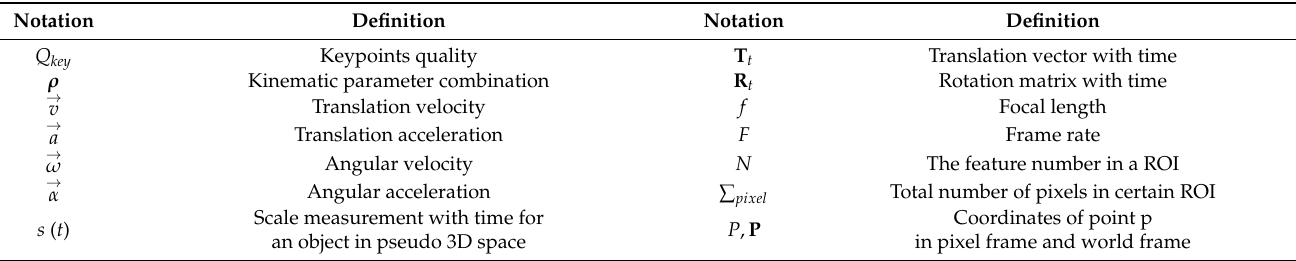
Table 1. Notations and